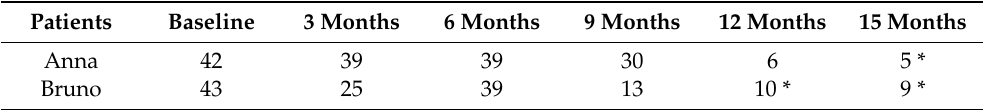
Table 1. PCL-5 scores. Patients